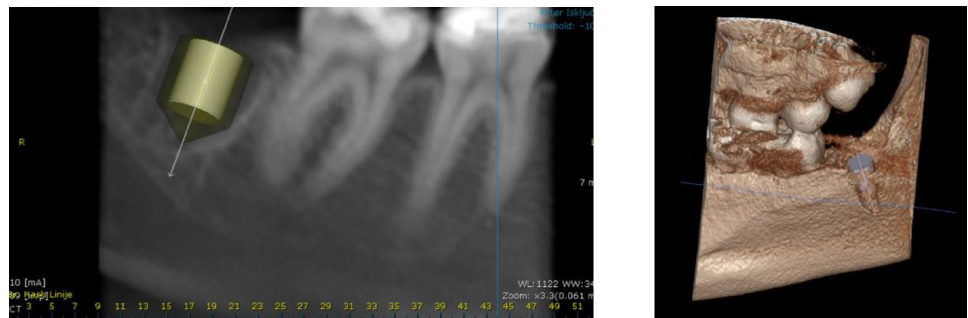
Figure 8. Implant positioning and bone density measurement in OnDemand3D software.